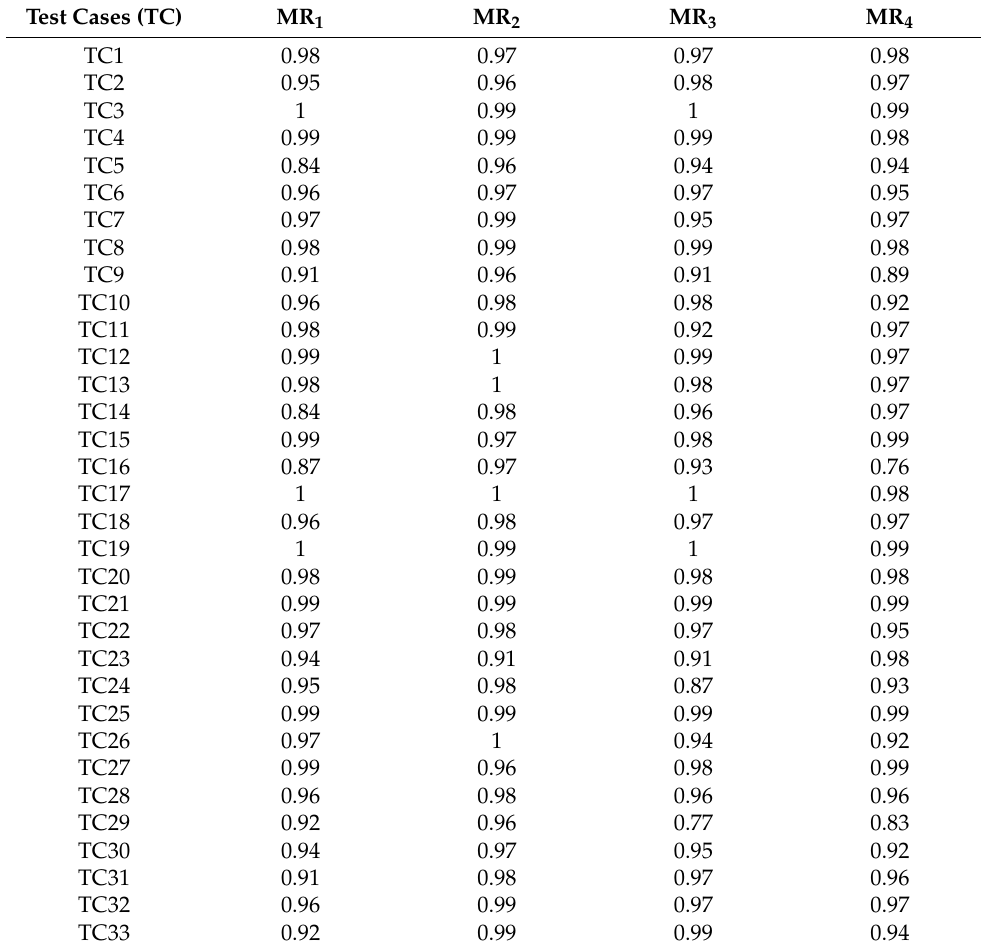
Table 8. SSIM value of flair